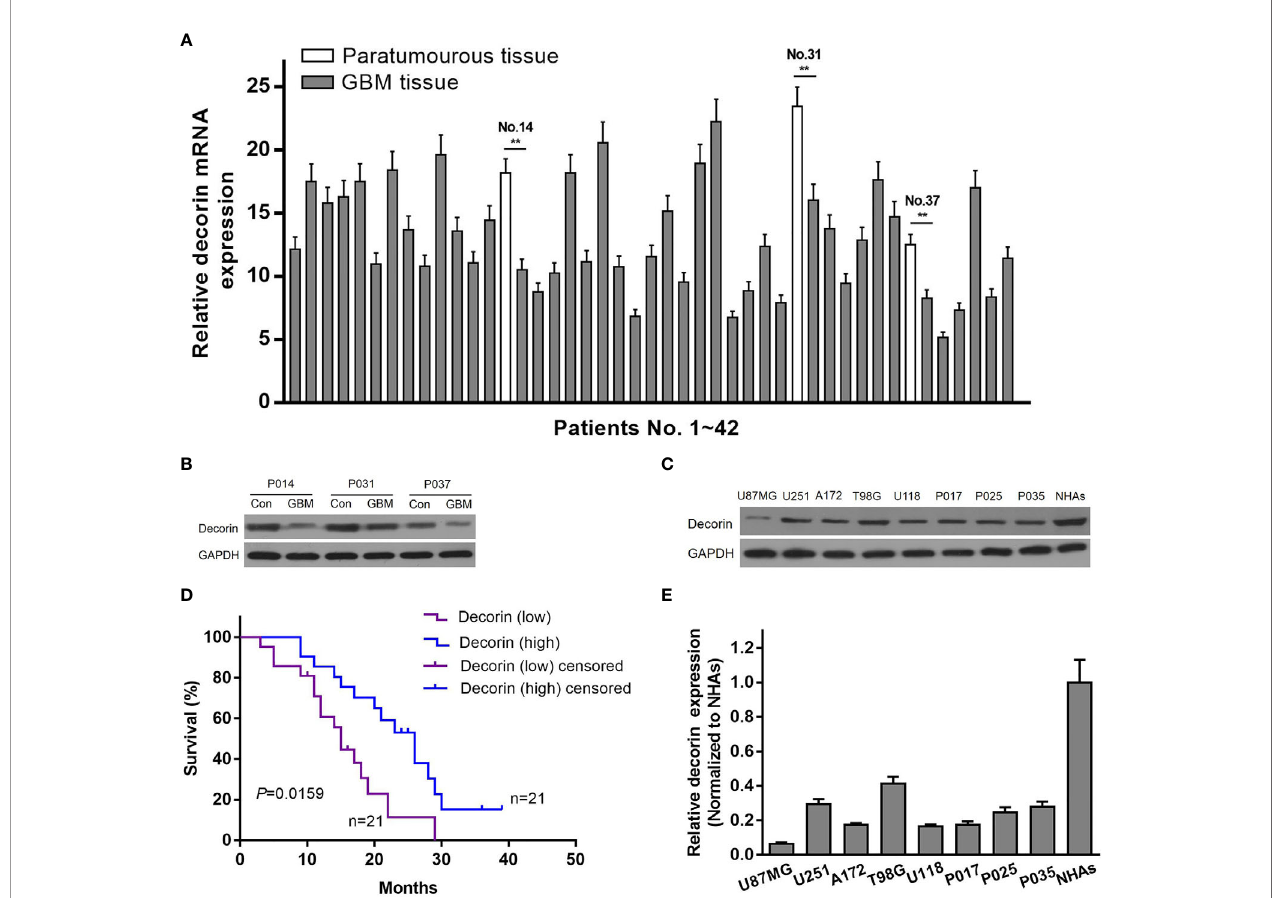
FIGURE 1 | Reduced expression of decorin in glioma tissues is associated with a poor survival. (A) The level of decorin expression was detected in 42 GBM samples and 3 paratumorous tissue samples using qRT-PCR. Values are means ± S.D. @ of 3 independent experiments.**P <0.01. (B) Western blot analysis in three paired tissue samples indicated that decorin was highly expressed in paratumorous tissues, while it had a lower expressions in GBM tissues. (C) Kaplan-Meier survival curve according to the levels of decorin expression. The 21 patients with higher decorin expression had signi fi cantly better overall survival than those with lower decorin expression (P = 0.0159). (D) Western blot analysis showed that decorin was highly expressed in human normal astrocyte cell line NHAs, while it had a lower expressions in established or primary glioma cell lines. (E) Measurement data of Western blot results (means ± S.D. @ of 3 independent